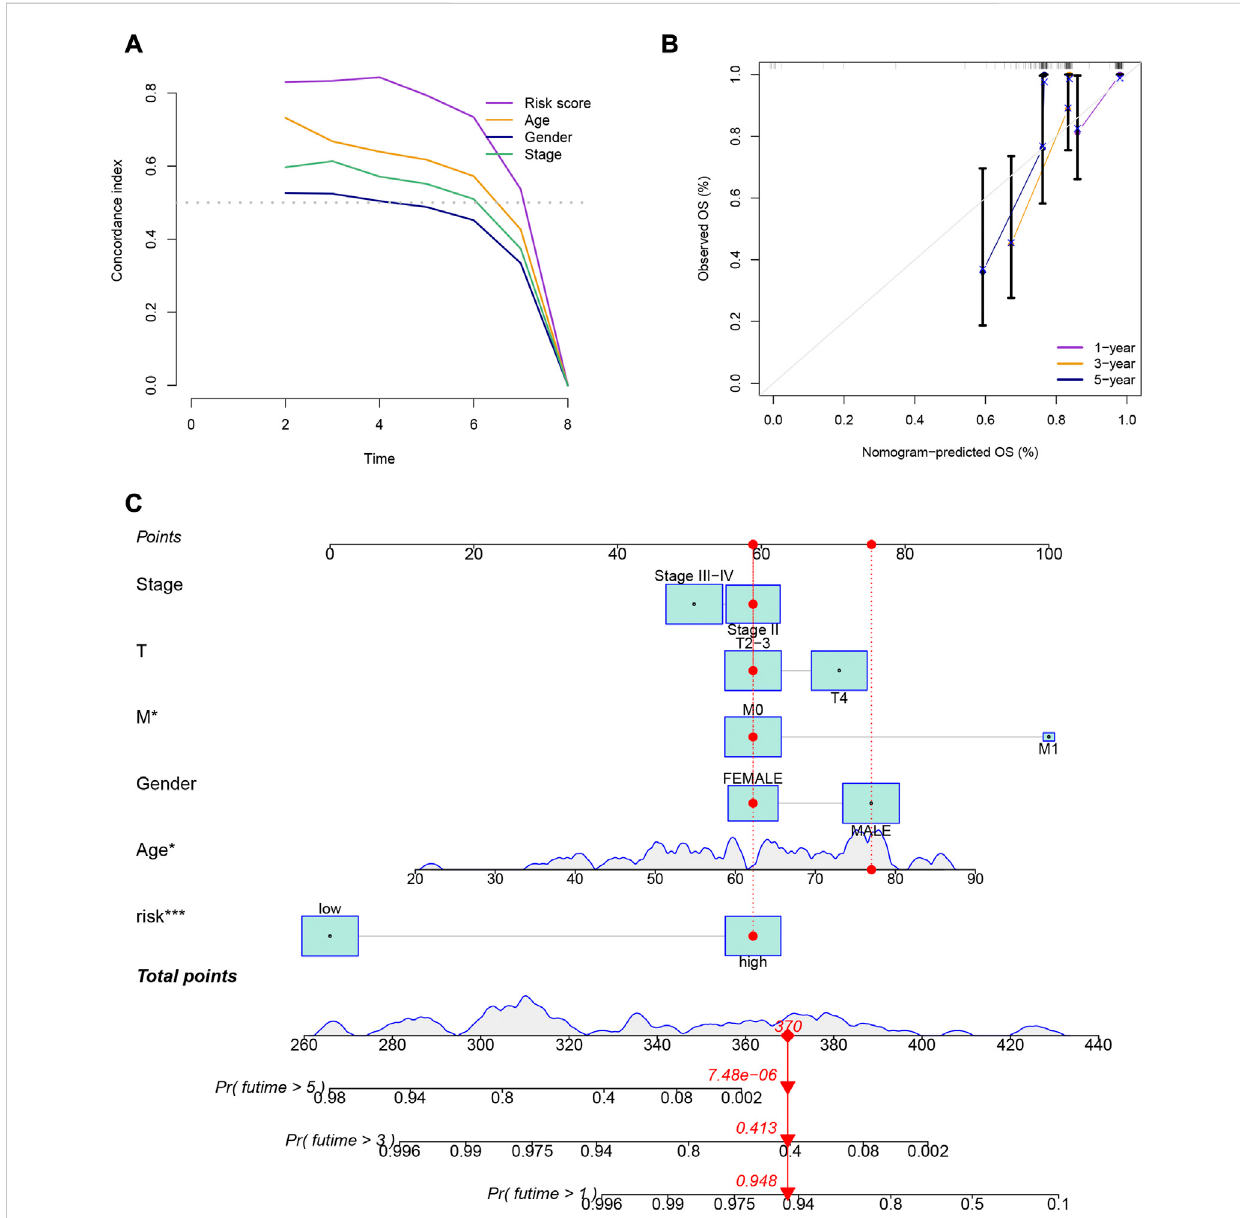
FIGURE 3 (A) Comparison of the gene expression signature with traditional clinical characteristics in predicting the prognosis of uveal melanoma patients. (B) Correlation plot of the predicted and observed survival rates at 1, 3, and 5 years. (C) Nomogram incorporating the gene expression signature and clinical characteristics to predict the prognosis of uveal melanoma